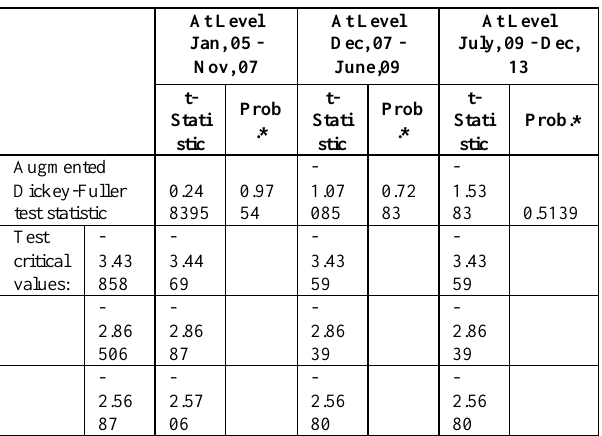
Table 1: The Results of ADF Test on Gold Prices (At